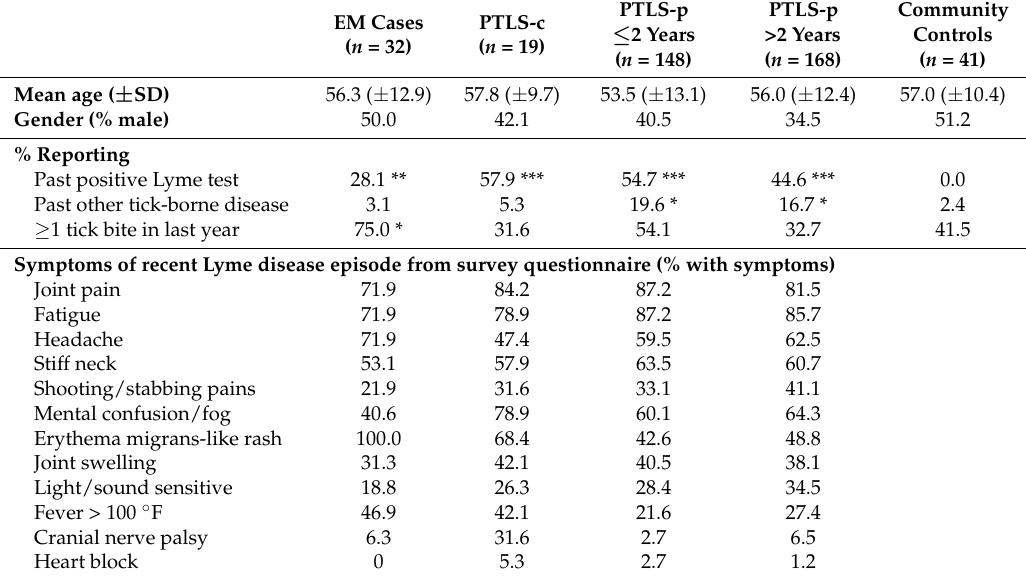
Table 3. Cohort characteristics and reported symptoms of case cohorts in Lyme-endemic communities, July